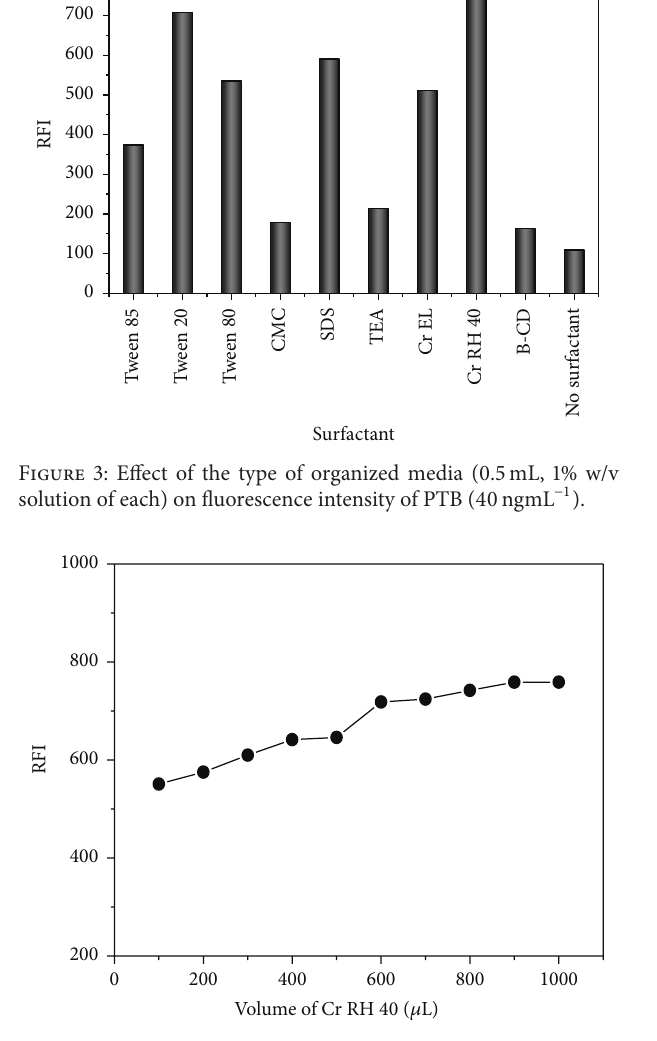
Figure 4: Effect of Cr RH 40 volume (1% w/v) on fluorescence intensity of PTB (40ngmL −1 ).